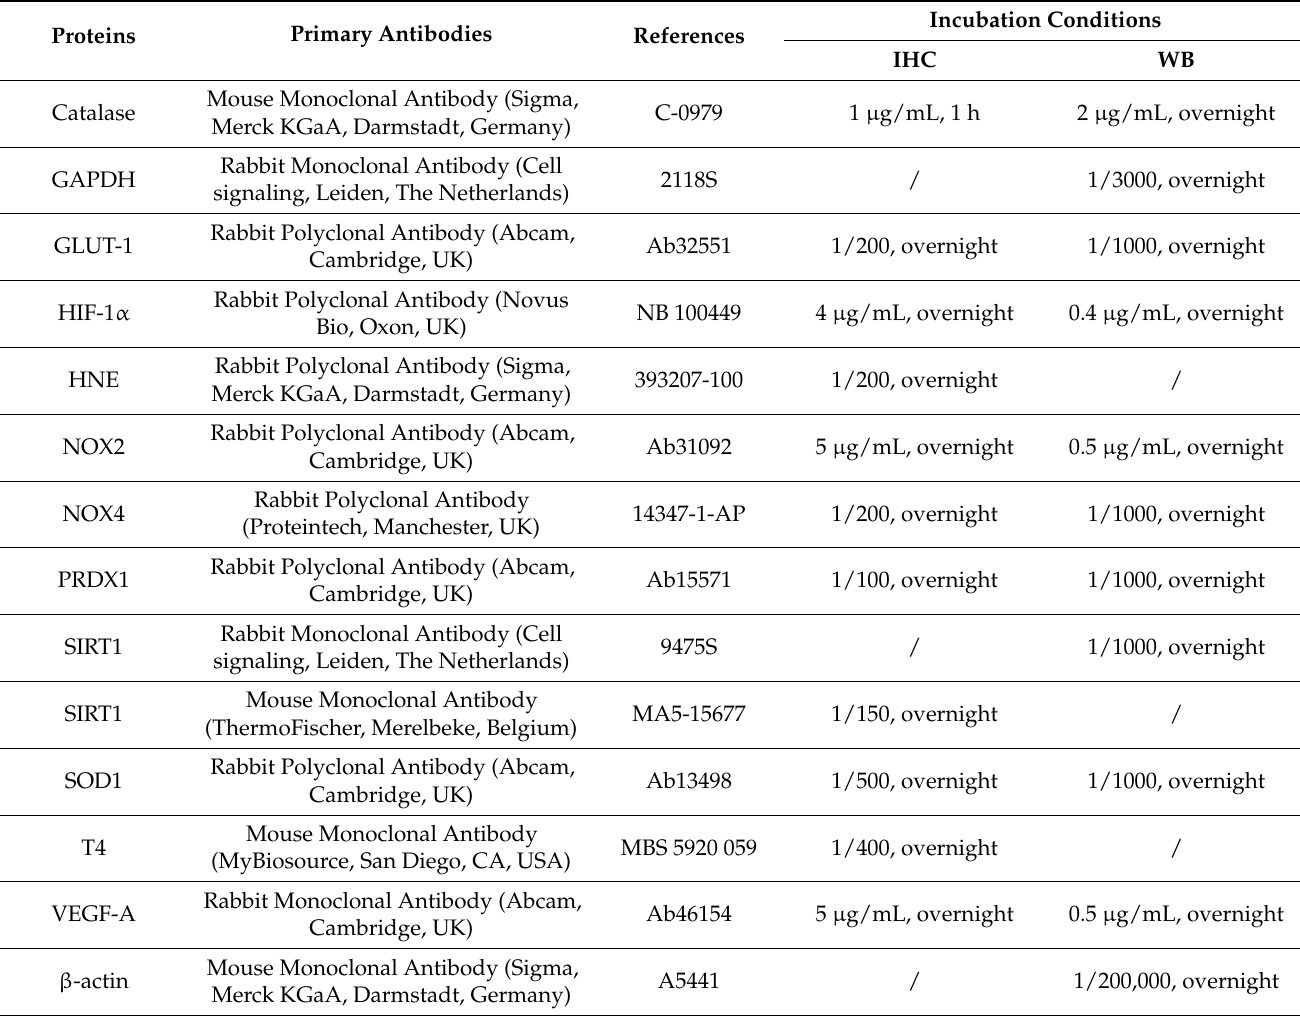
Table 2. Experimental conditions for immunohistochemistry (IHC) and Western blot (WB).